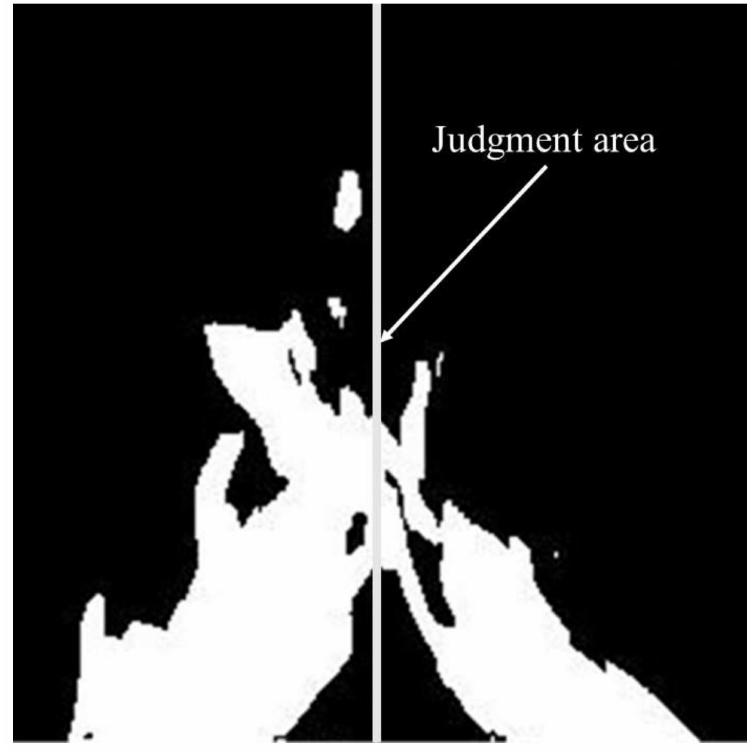
Figure 4. Schematic diagram of flame-merging judgment